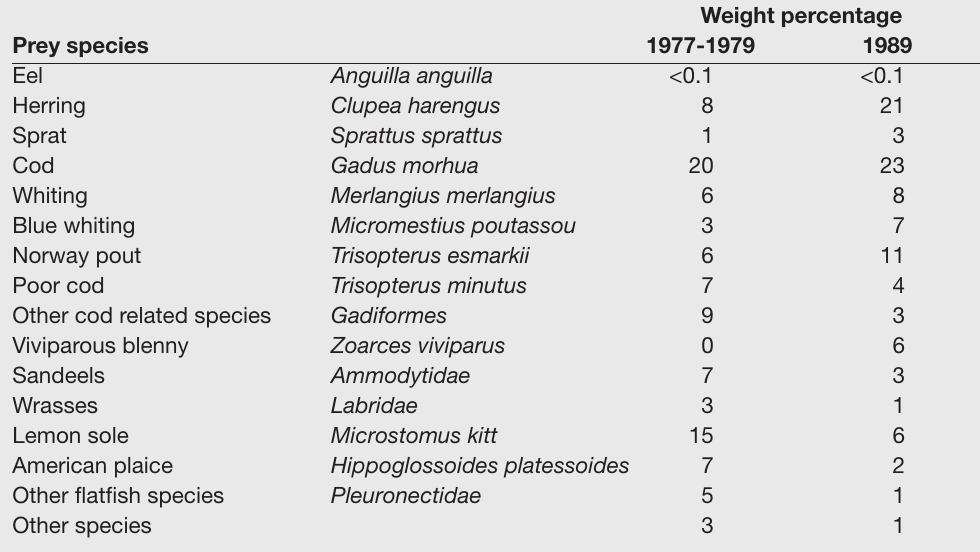
Table 4. Prey-species composition of harbour seals in the Koster archipelago during the periods 1977-1979 and 1989. Figures indicate percentage by weight. Data obtained from Härkönen (1987) and Härkönen and Heide-Jorgensen